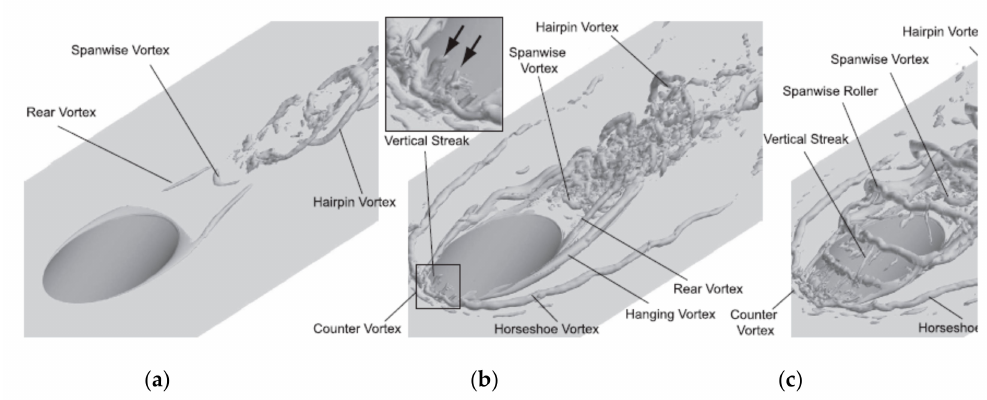
Figure 22. Comparison of the vortical structures around the nozzle exit for different values of blowing ratios ( BR ) including ( a ) BR = 0.1, ( b ) BR = 0.7, and ( c ) BR = 1.0